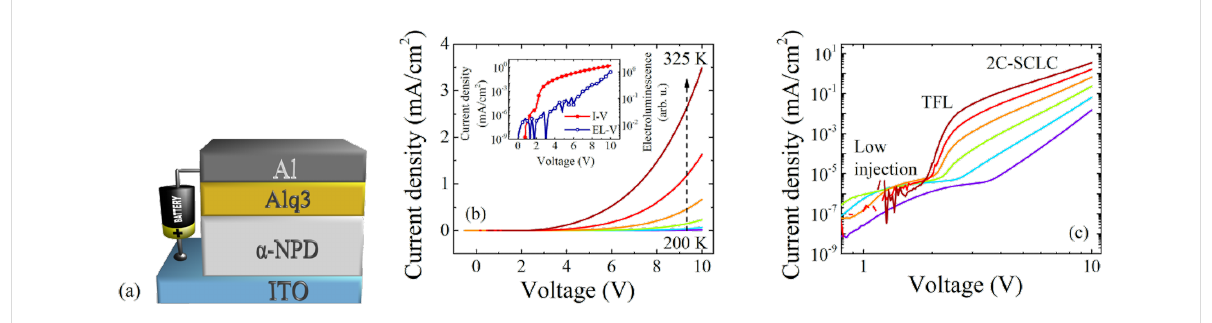
Figure 1: (a) Schematic diagram of the device ITO/ α -NPD/Alq3/Al. Steady-state current–voltage characteristics (b) in linear scale, the inset shows current density–voltage characteristic and electroluminescence–voltage characteristic at 300 K in a semi-log scale, and (c) in log–log scale recorded over temperature range from 200 to 325 K. Abbreviations TFL and 2C-SCLC stand for trap-fill-limit and two-carrier space-charge limited conditions,